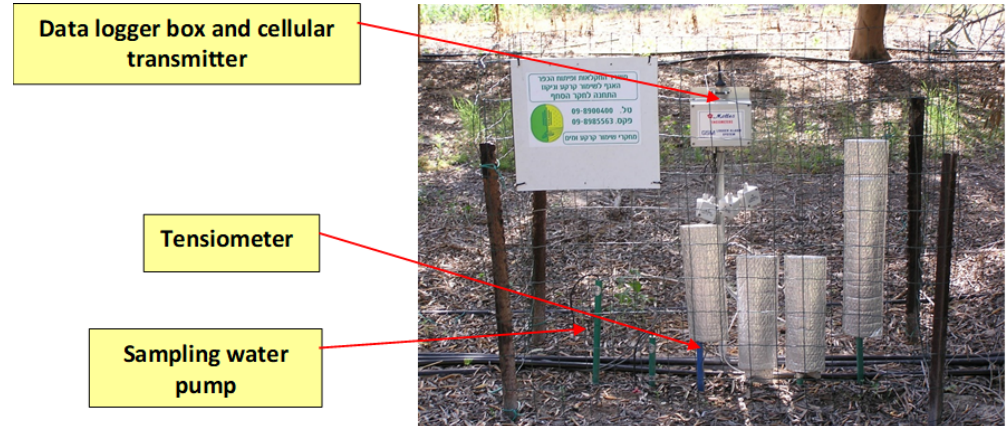
Figure 5. Transmitting tensiometer